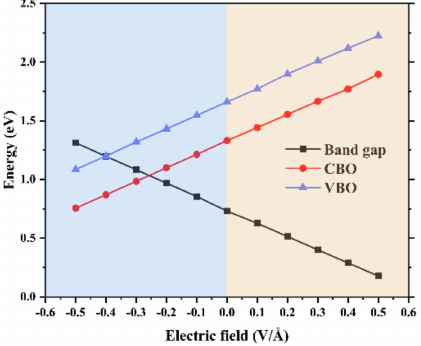
Figure 6. Band gap and band o ff sets of the SiS 2 / WSe 2 hetero-bilayer as a function of the external electric field.